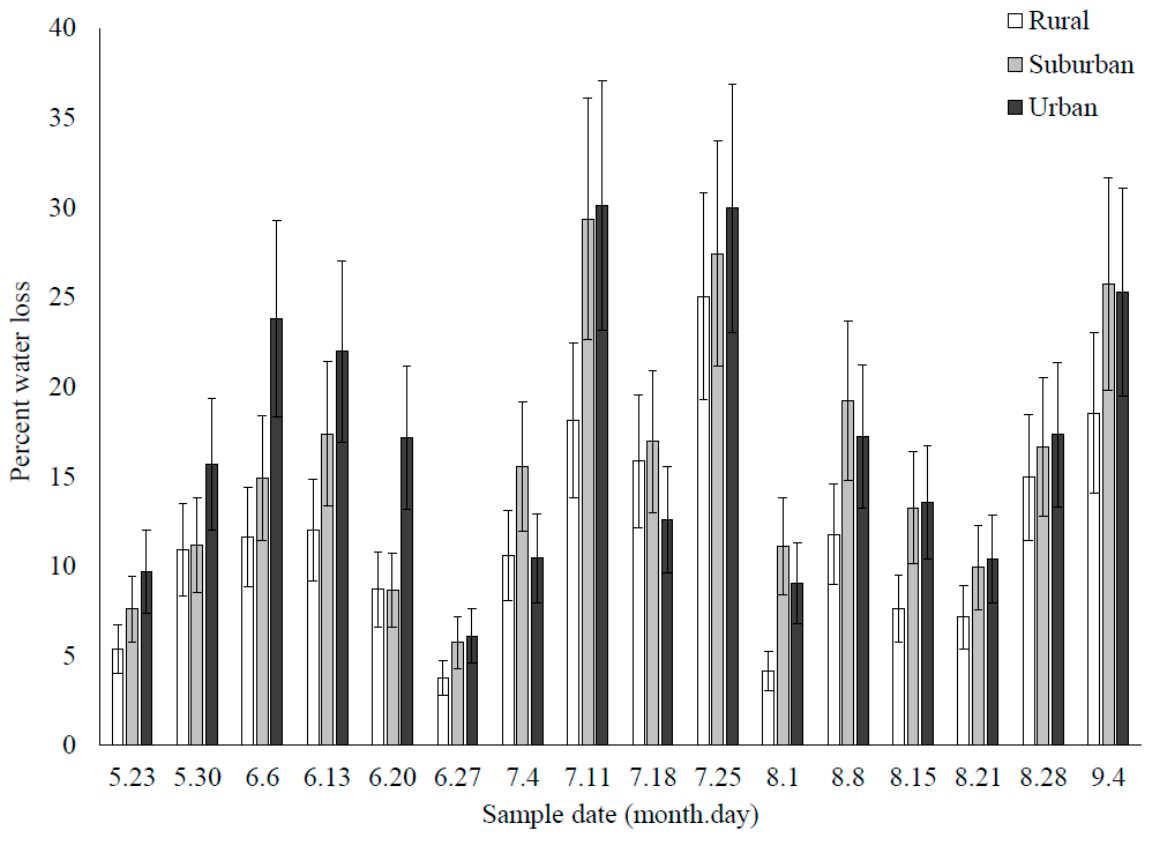
Figure 4. Ovicup hydroperiod, measured as weekly percent water loss in 2018.